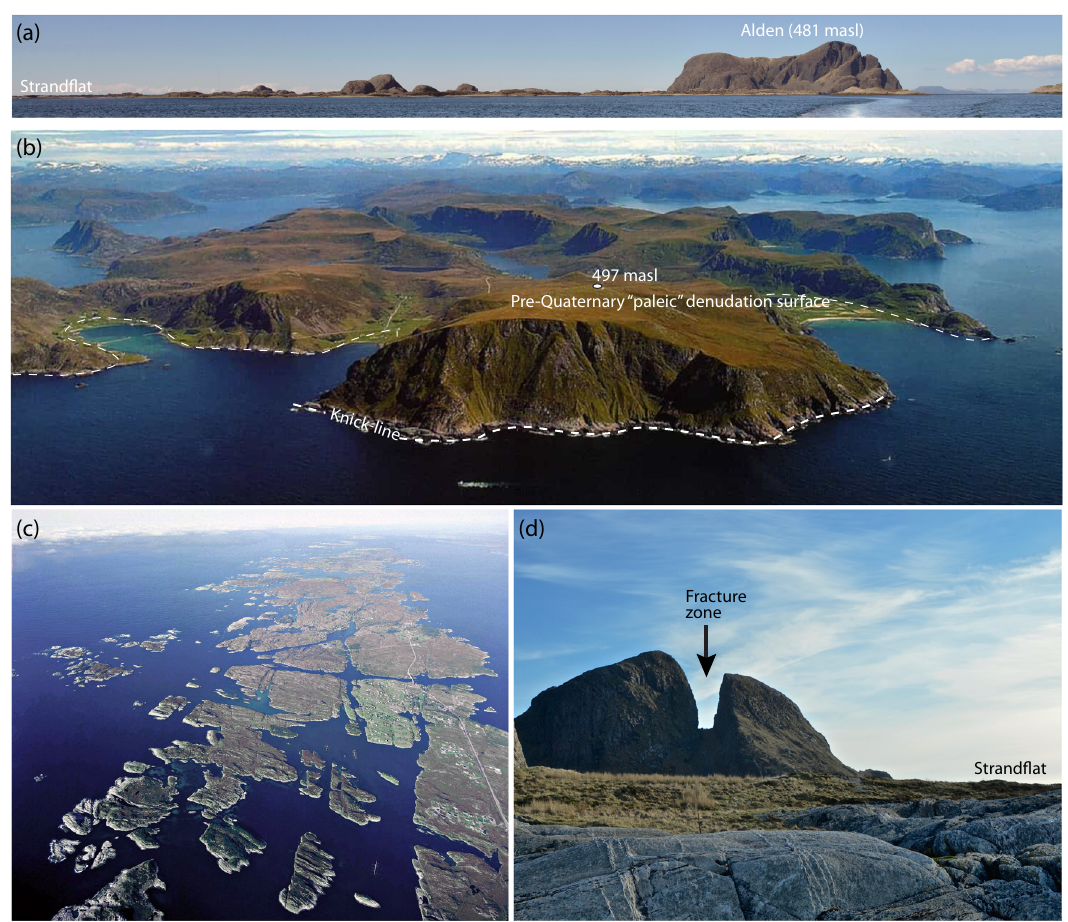
Fig. 7 Photos of some characteristic strand fl at features. a Strand fl at (mostly sumberged) and remnant (monadnock) mountain Alden with further degenerated knobs to the left (west). b View to the E from the eastern limit against a higher and older plateau-like landscape in Stad. The landward limit of the subhorizontal strand fl at is marked by a knick-line against a cliff-face that levels out to de fi ne an older “ paleic ” surface, in this area at around 400 – 500 m above sea level, with the highest peak of the peninsula at 645 m. Photo: J. Kråkenes. c The strand fl at in Øygarden, teared up by fault and fracture zones. d Fracture zone,